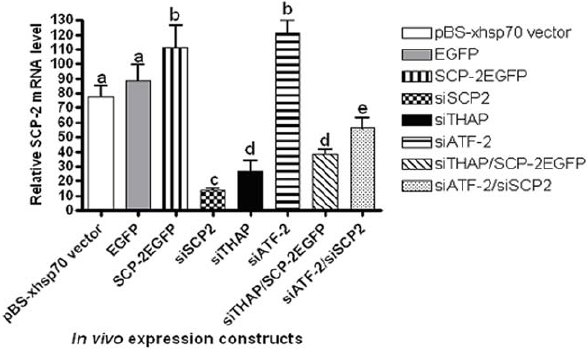
Figure 5. In vivo AeSCP-2 transcription in the larval midgut under the influence of transfected expression vectors. The siRNA vector is driven by the Drosophila hsp70 short promoter. Constitutive over expression is drive by the Baculovirus immediate early gene promoter [17]. In the co-transfected groups, two expression vectors were added at 1:1 ratio. In the single expression vector groups, pBS vector plasmid was added in at 1:1 ratio to normalized the total amount of expression vector each group received. Larvae were synchronized on Day 1 2 nd instar; siRNA expression was induced via heat shocked at 37 u C for 24 hours on Day 1 of 2 nd and 4 th instar, respectively. Heat shock-treatment was not applied to the EGFP and SCP-2EGFP groups. Day 1 4 th instar larvae (10 larval midguts/sample) were taken after the 2 nd heat shock-treatment. Relative (vs. rpL8 ) AeSCP-2 mRNA levels from each sample were determined via RT-qPCR. Mean and standard deviation are shown (N=3). The same letters above the bars in each construct represent that the mean values did not differ from other constructs significantly (p . 0.05) in paired t-tests with the vector